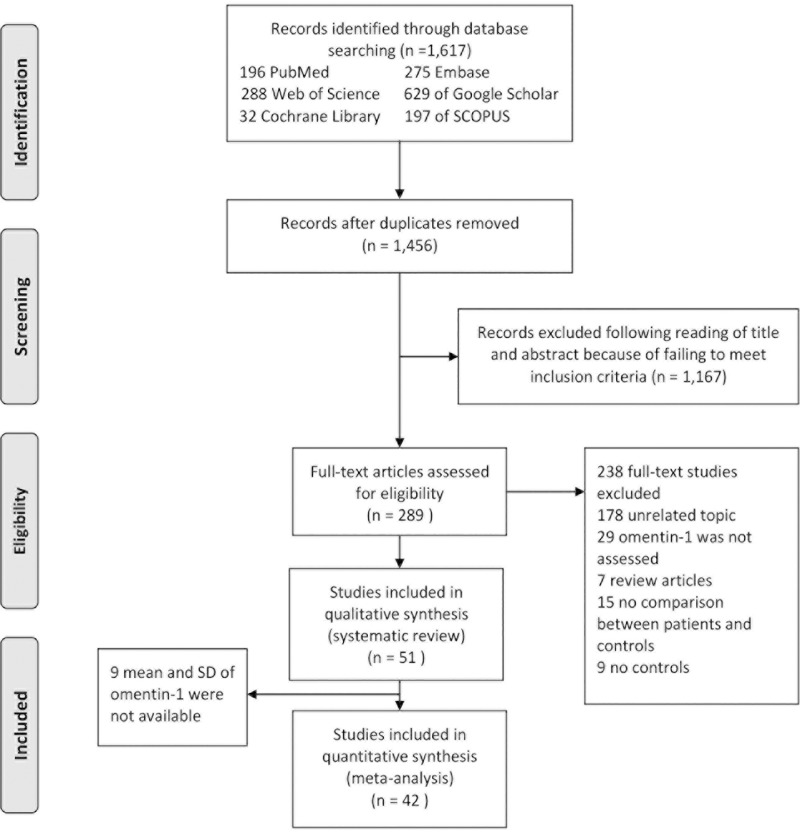
Flowchart of study selection.Showing the process by which relevant studies were retrieved from the databases, assessed, and selected, or excluded. Preferred reporting items for systematic reviews and meta-analyses (PRISMA) diagram for study search.